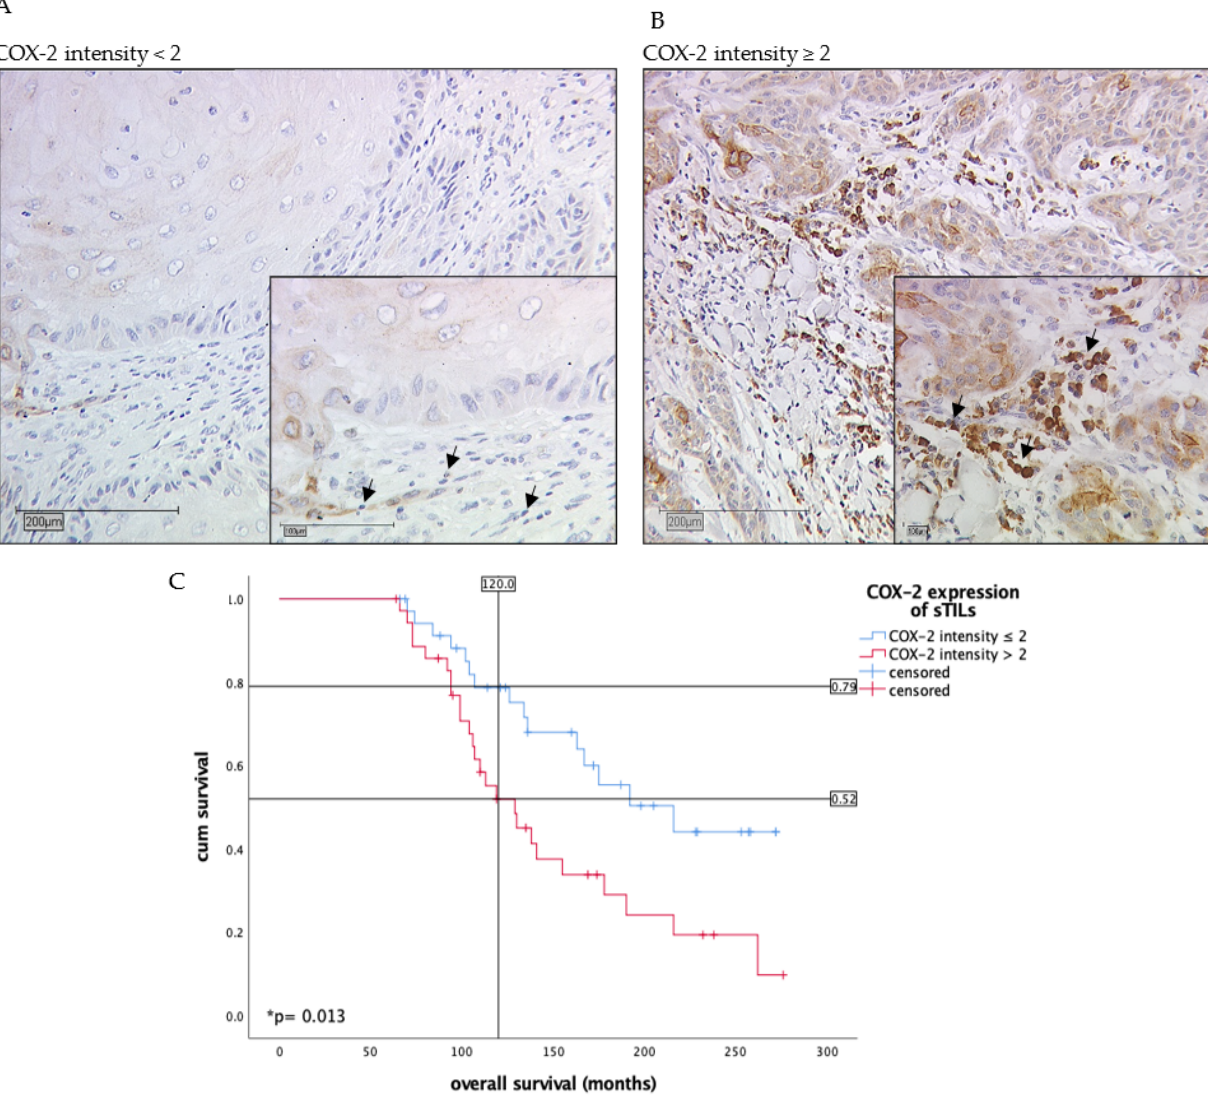
Figure 1. Immunohistochemistry staining of COX-2 (10× and 25× magnification) in vulvar cancer tissue showing expression of stromal sTILs with intensity of COX-2 expression < 2 ( A ) and ≥ 2 ( B ). The arrows in both figures mark exemplarily sTILs ( A , B ). The Kaplan–Meier curve shows a significantly worse overall survival rate for the patients with a strong COX-2 intensity of sTILs > 2 in long- term survival of 10 years (* p = 0.013, ( C )). ( C ) is labeled with the percentage of patients with vulvar carcinoma still alive after 10 years: In the group of patients with COX-2 expression of sTILs ≤ 2 of vulvar carcinoma, 79% are still alive, whereas among the diseased women with higher COX-2 expression of sTILs, only 52% are still alive in comparison. Table 1. There is a clear difference in long-term overall survival after 10 years for patients with intensity values for COX-2 expression in sTILs >2. Patients with intensity values >2 live with a me- dian of 129 months, whereas patients with lower IRS values survive 216 months. As the table shows, the survival of patients of both groups differs by 87 months, i.e., more than 7 years. Even in the total group, a survival difference is recorded: patients live a total of 163 months, but still lose 34 months of life with higher intensity values.